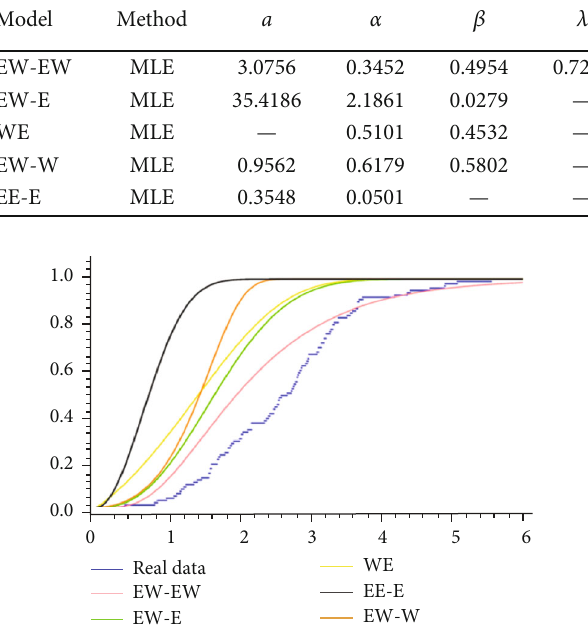
Table 6: Parameter estimates and values of AKINC, COAKINC, BINC, and HQINC for the 2 nd data. Model